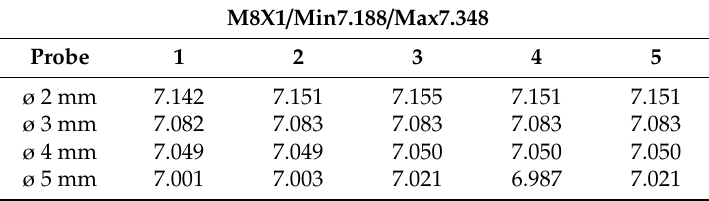
Table 3. Diameters of the thread, found by measuring using 4 probes and 5 measurements.